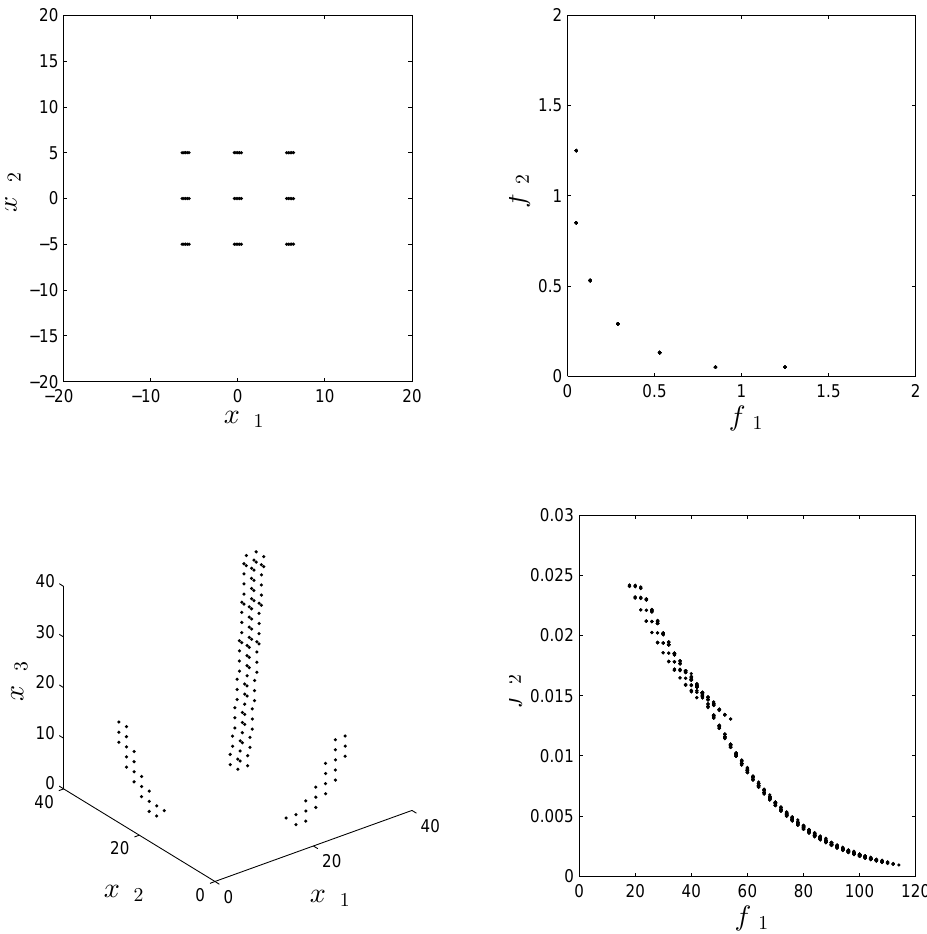
Figure 3. Numerical results of GCM on the academical problems. Decision space ( left ) and objective space ( right ) obtained on the problems sym-part and SSW from above to